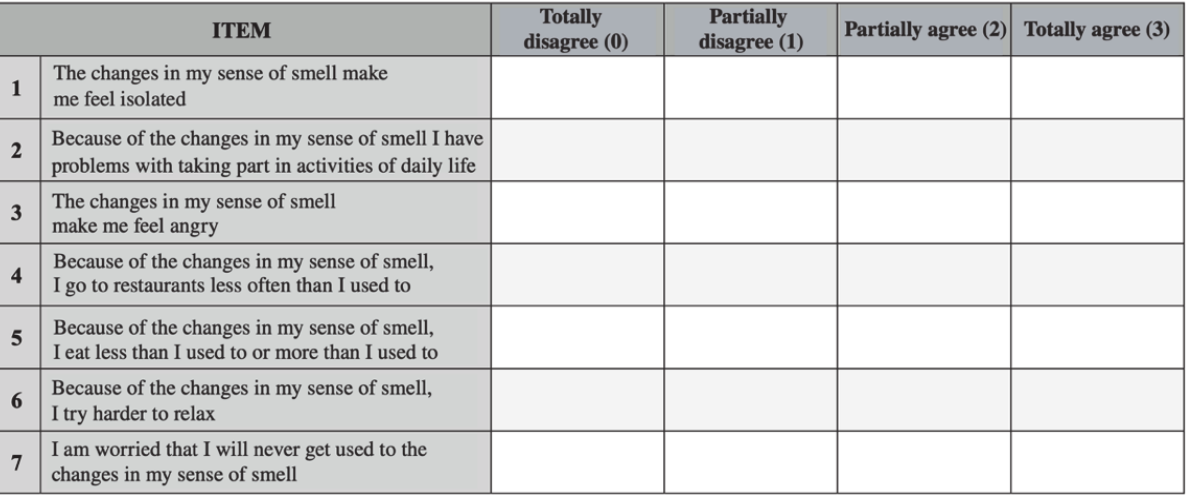
Figure 2. English version of Questionnaire of Olfactory Disorders—Negative Statements (svQOD ‐ NS) .